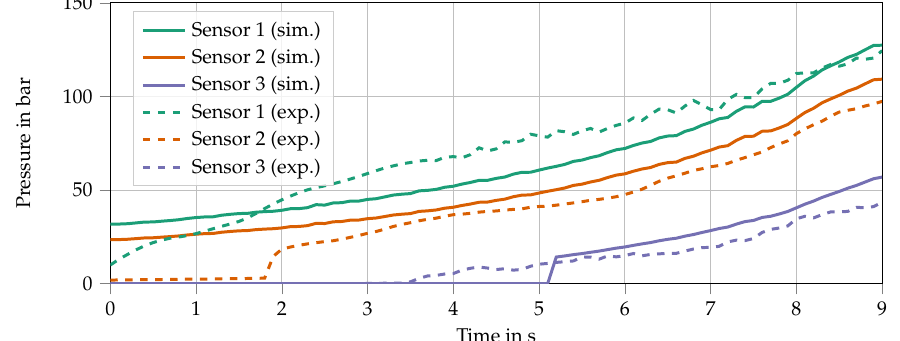
Figure 3. Exemplary fitting results of the predicted local stresses based on viscosity and friction stresses and comparison with the measured pressure from the rheological molding